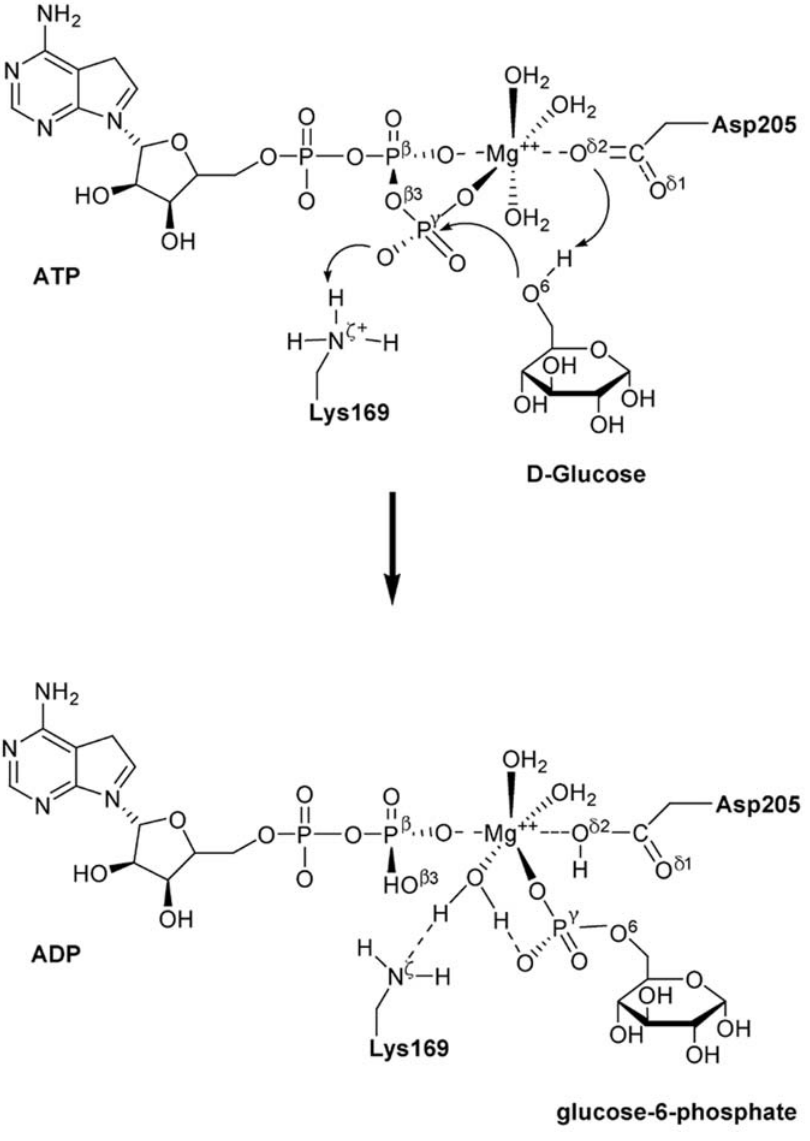
Figure 5. Reaction mechanism of glucose phosphorylation catalyzed by the wild-type GK.